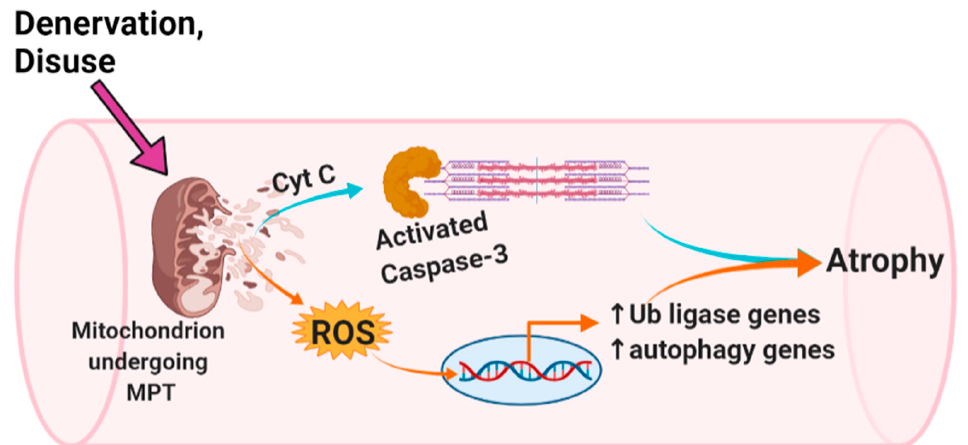
Figure 1. Hypothesized mechanism of mitochondrial permeability transition (MPT)-induced skeletal muscle atrophy. In this scheme, MPT causes atrophy by recruiting previously established mechanisms of muscle atrophy involving caspase 3 activation and mitochondrial ROS-induced upregulation of atrogenes and autophagy genes. This figure was created using Biorender.com.